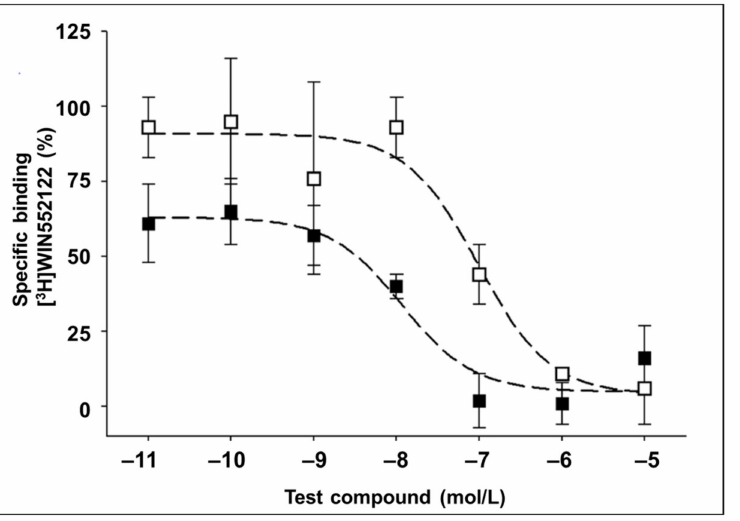
Figure 2. Receptor binding assay to determine the affinity of cis - 5 ( LU14 , filled squares) and trans - 5 (open squares) for human CB2 receptors. A direct comparison reveals the higher affinity of the cis -isomer. Human CB2 receptors were expressed in CHO cells, and affinities were determined by competitive radioligand displacement experiments using [ 3 H]WIN552122. Inhibition curves were obtained by non-linear regression of percent specific binding (mean ± SD; one experiment run in triplicate) plotted versus log concentration of the test